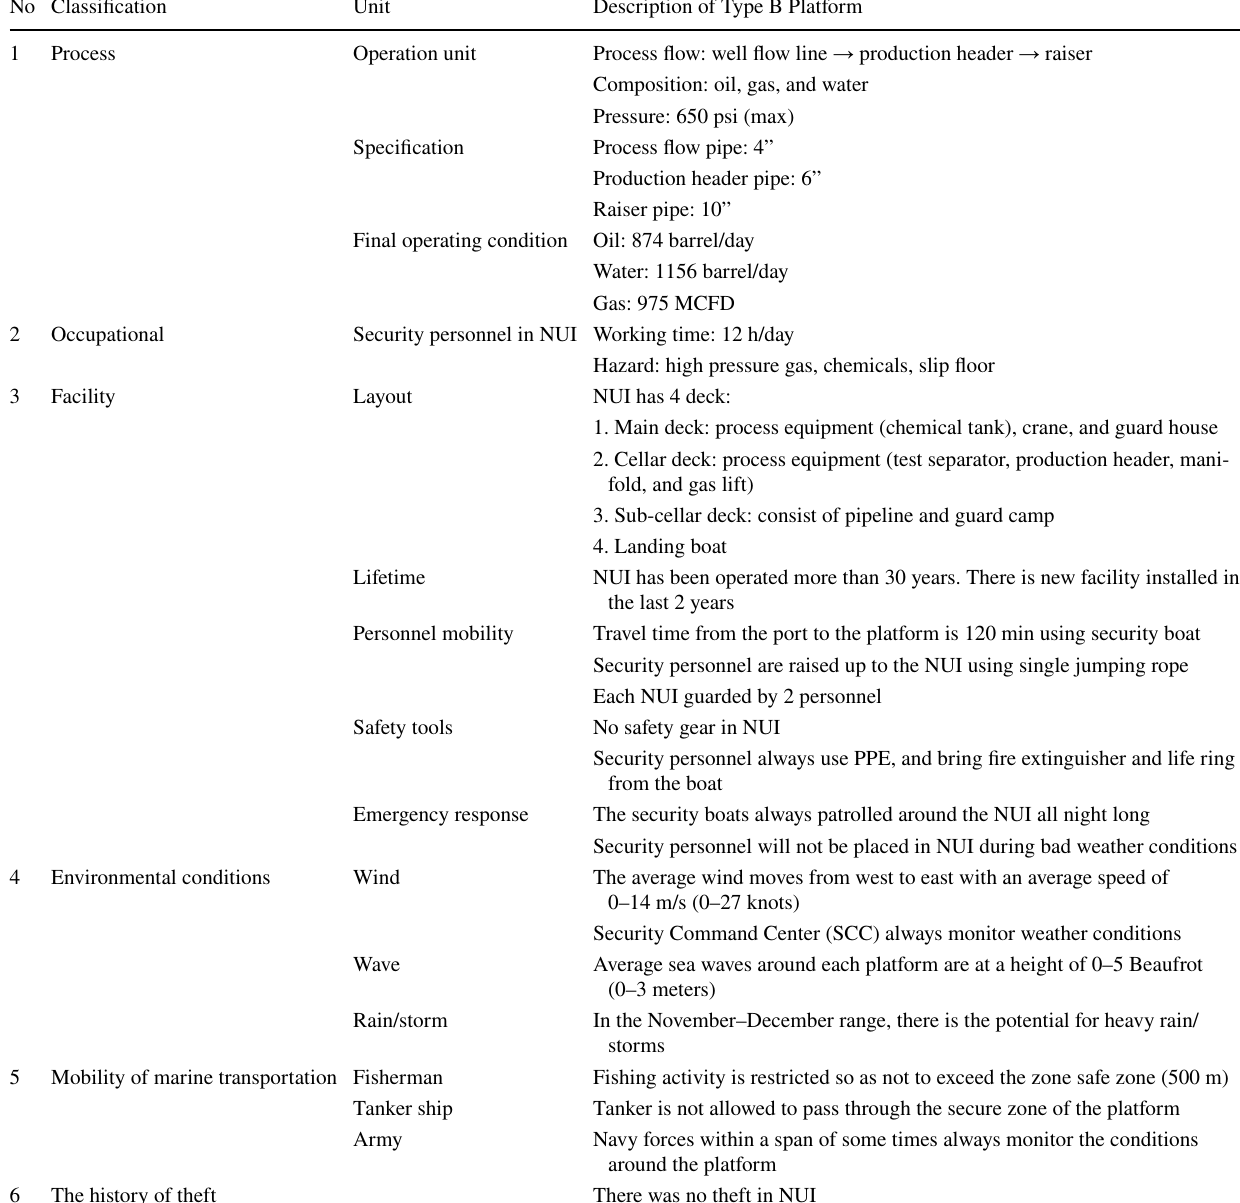
Table 2 Description of type B platform No